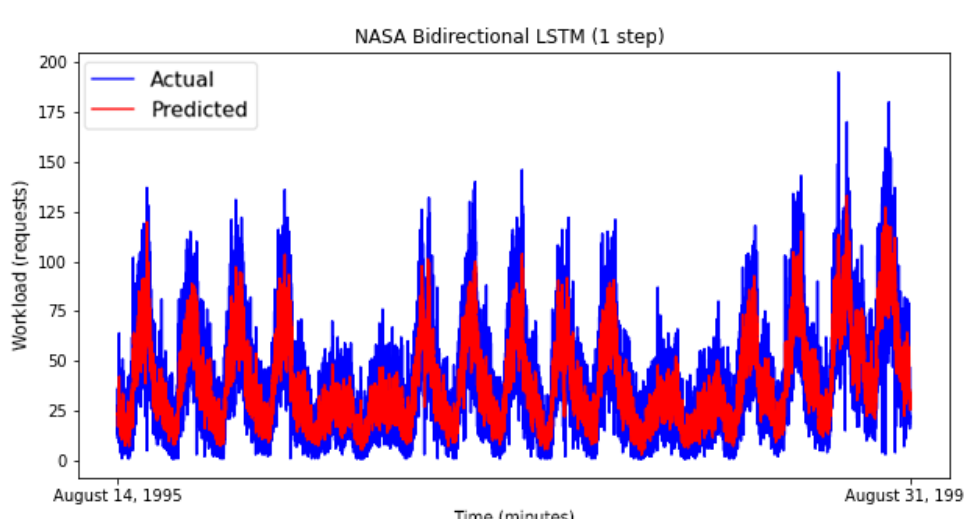
Figure 7. ARIMA with one-step prediction on the testing set.